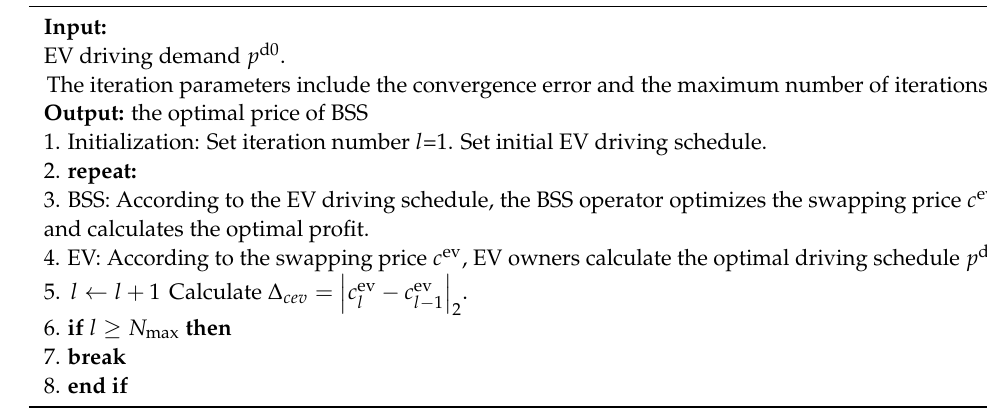
Algorithm 2. BSS pricing iteration method.